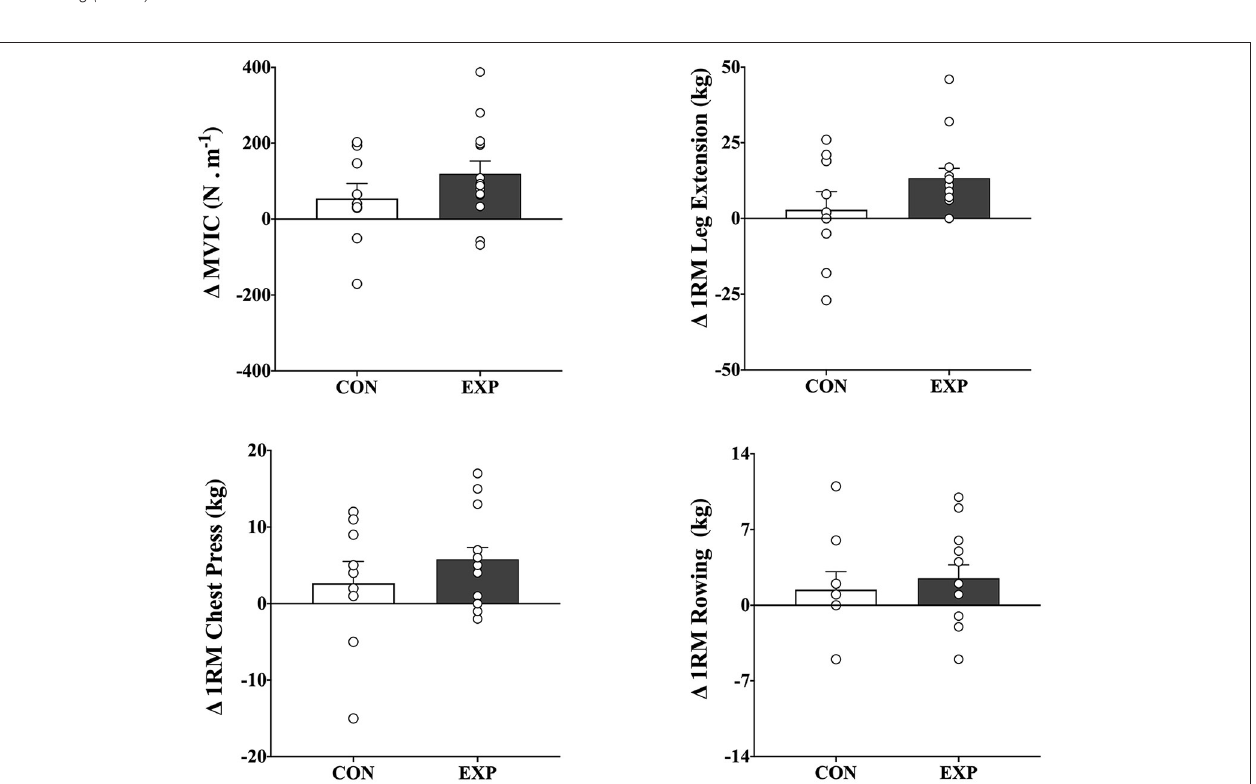
differences in change scores among the groups were